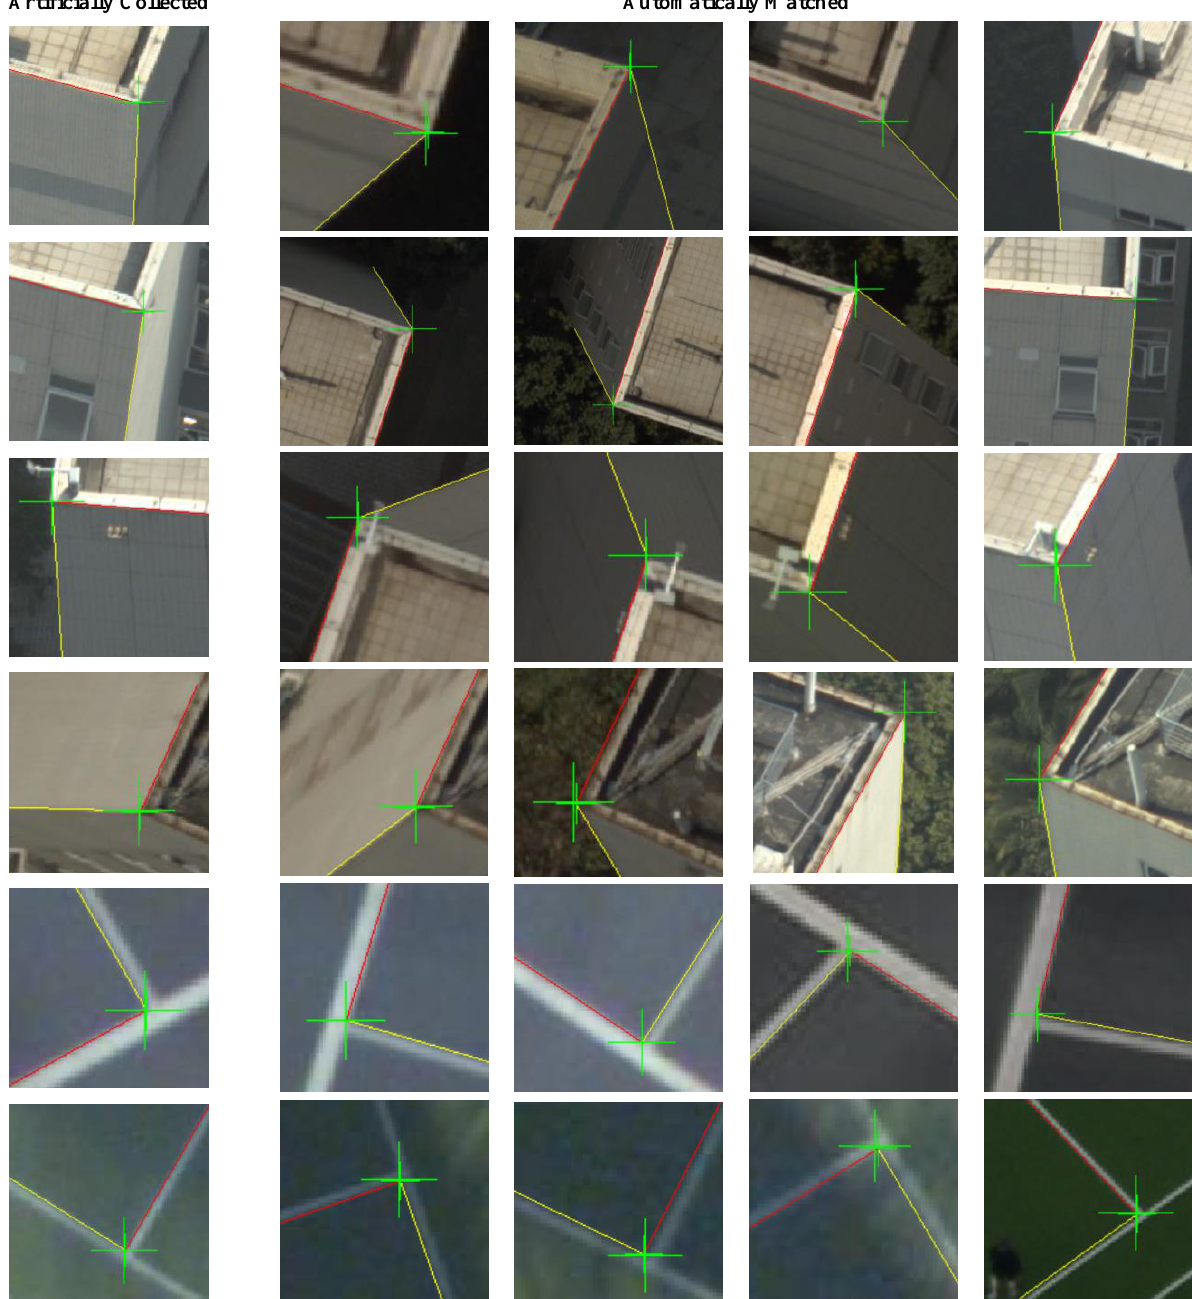
Figure 8. The screen-shots of the artificially collected L-junctions (the first column) and the automatically matched